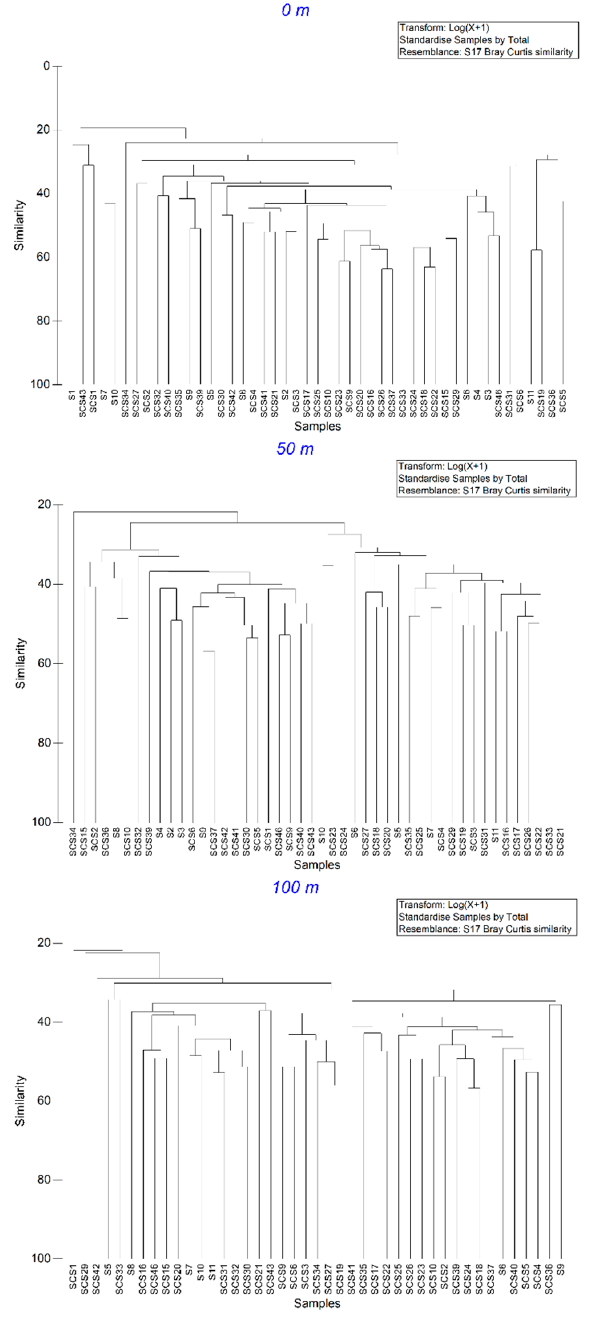
Figure 8. Hierarchical cluster analysis of phytoplankton community